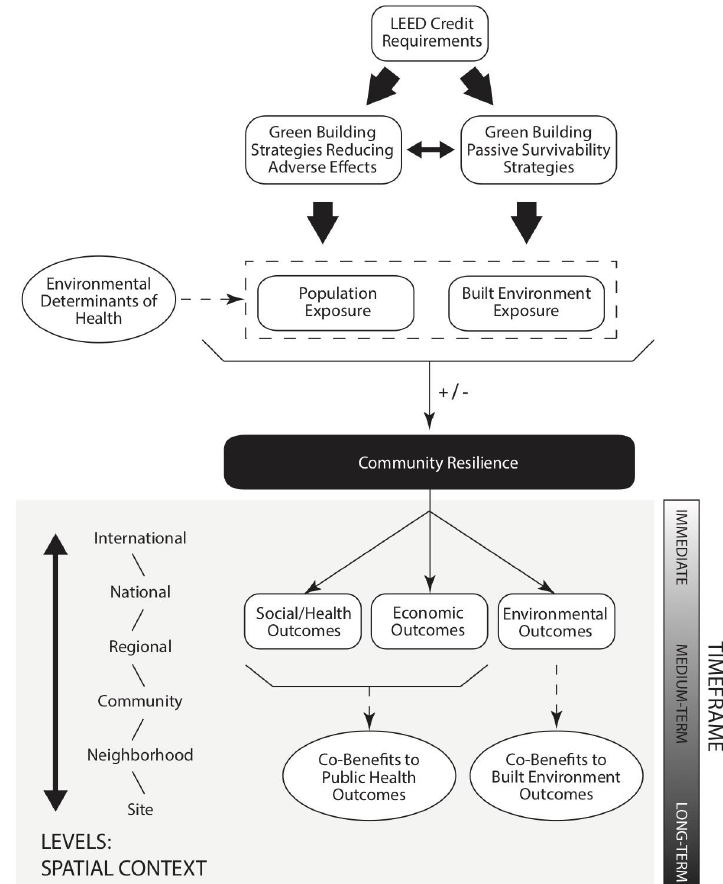
Figure 1. Conceptual framework: establishing an evidence base for associations between Leadership in Energy and Environmental Design (LEED®) credit requirements and climate change resilience